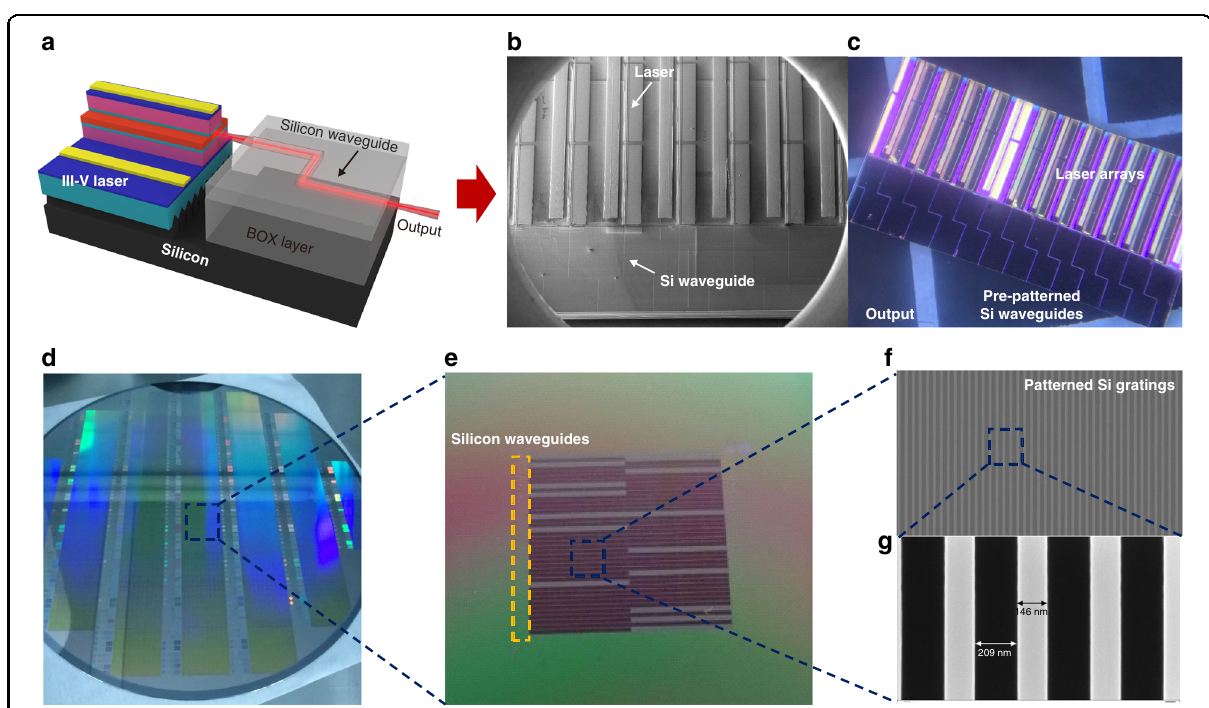
Fig. 1 Monolithically integrated embedded InAs QD lasers on SOI characterizations in this work. a Schematic of monolithic integration of III-V QD laser edge coupled with silicon waveguide on SOI platform. b Top-view SEM image of InAs QD laser arrays grown in pre-patterned laser trenches, with passive silicon WGs. c Optical microscope image of entire integrated chip. d 8-inch SOI wafer with pre-patterned laser trenches and silicon waveguides. e Zoomed-in optical microscope image of laser trenches with aligned silicon waveguide arrays on SOI substrate. f Top-view SEM image of patterned silicon grating structures inside laser trenches for III-V growth. g Magni fi ed silicon gratings with slab width of 146 nm and gap width of 209 nm. The duty cycle of this grating is approximately 40% inside the laser